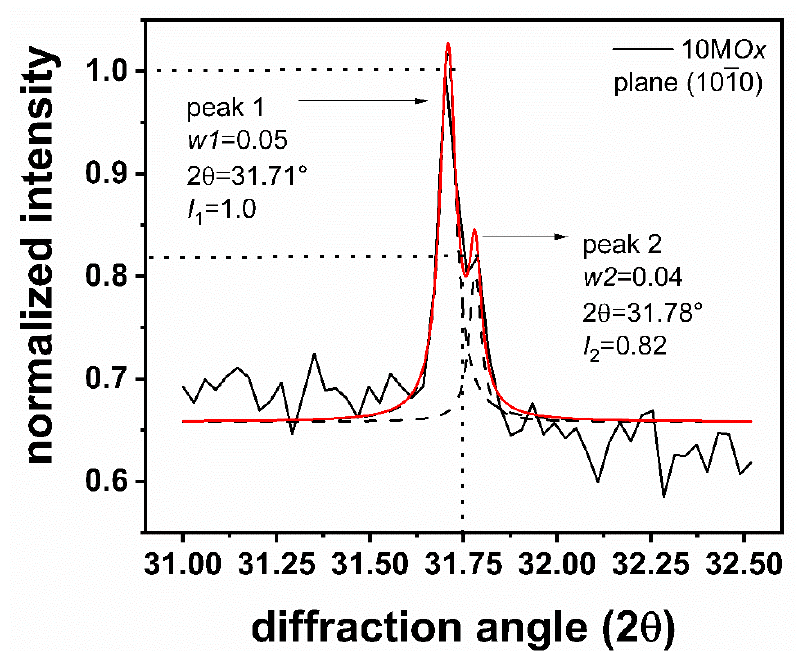
Figure A1. Enlarged view of the XRD pattern corresponding to ZnO film 10MOx, in the 2 θ range 31.0–31.50 ◦ . Shown also are the fitted curves and the obtained fitting parameters, which were used to calculate the texture coefficient (TC) and average grain size ( D ) shown in Table 1.